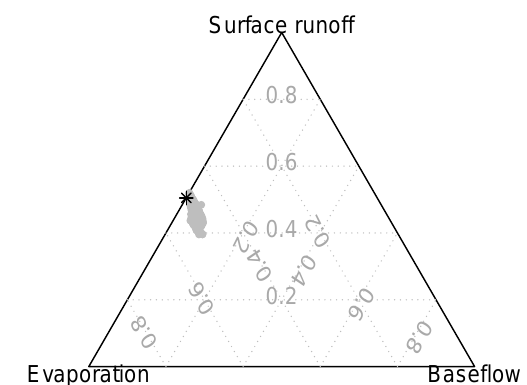
Figure 11. De Finetti diagram (ternary plot) of evaporation, surface runoff, and baseflow with MOO (grey) and SOO (black